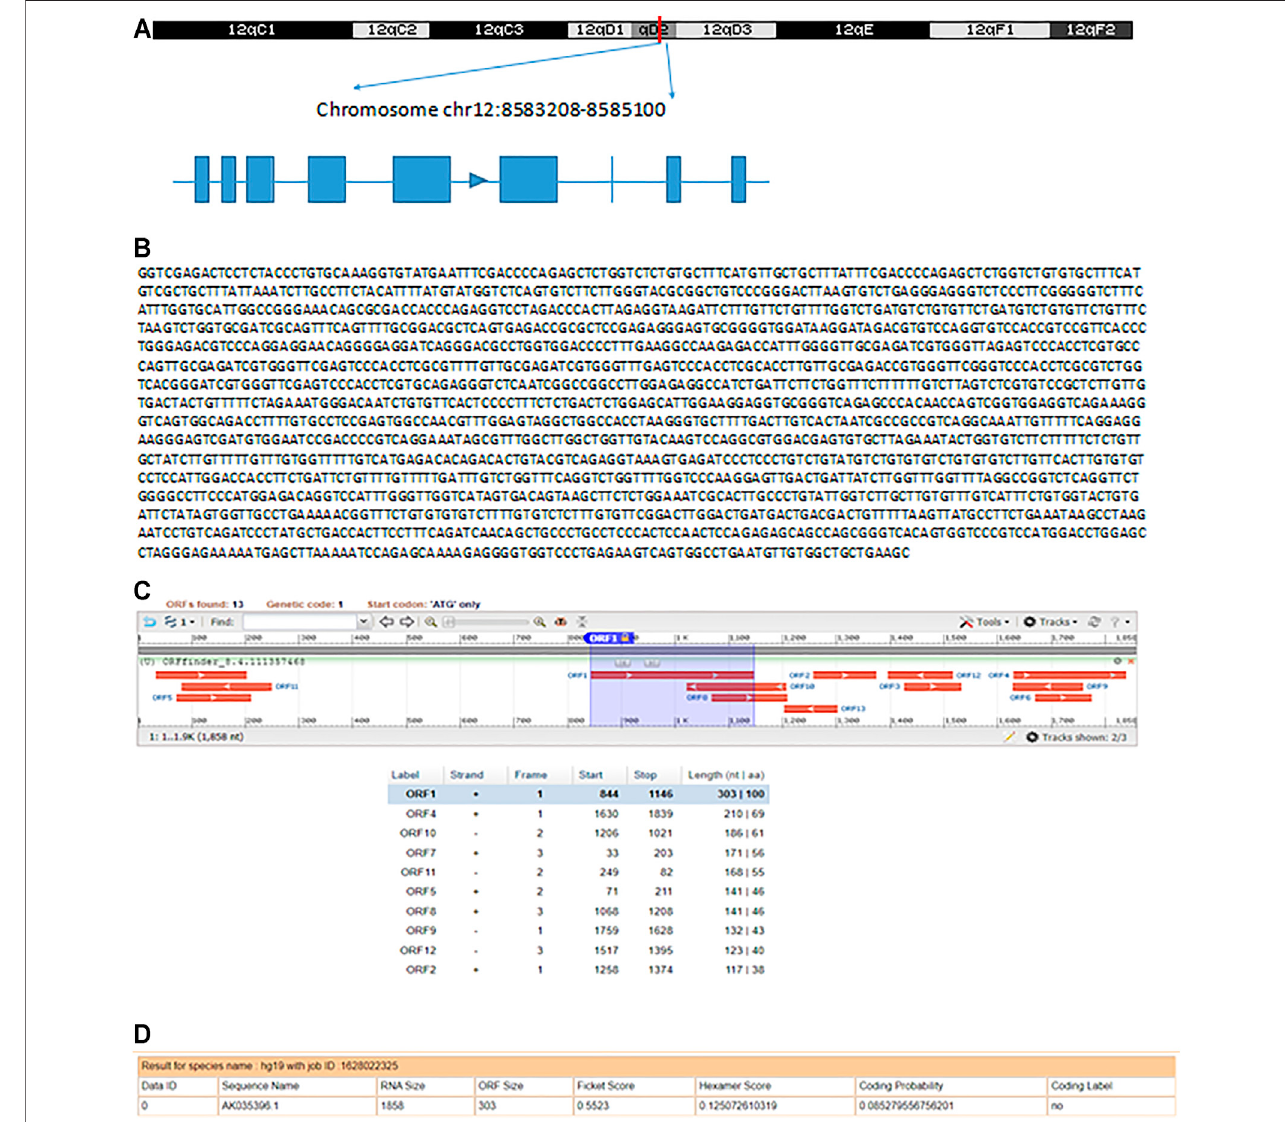
FIGURE2| Identi fi cationandcharacterizationofAK035396. (A) SchematicdiagramofAK035396fromEnsemblRefSeqandRACE.Blueboxes:exonsannotated byNCBI RefSeq.Bluelines:introns.Thearrowson thebluelines indicate transcriptional directions. (B) Thefull-lengthsequenceoftheAK035396transcript. (C,D) ORF fi nder software (C) and CPAT software. (D) Prediction of the protein-coding potential of AK035396.